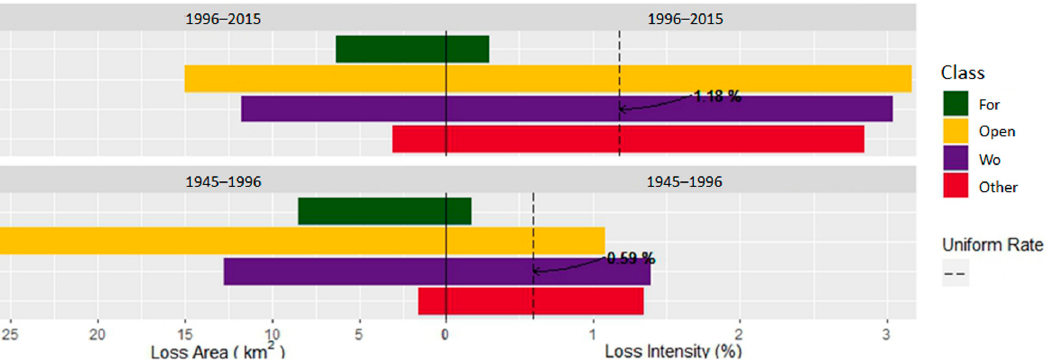
Figure 7. LULC class level intensity analysis for area loss in the study area for the periods 1945–1996 and 1996–2015. Bars that extend to the left of zero axis show the gross surface loss for each LULC class. Bars that extend to the right of zero axis show the intensity of loss for each class. For the explanation of the vertical, dashed line and the LULC classes, see Figure 6.